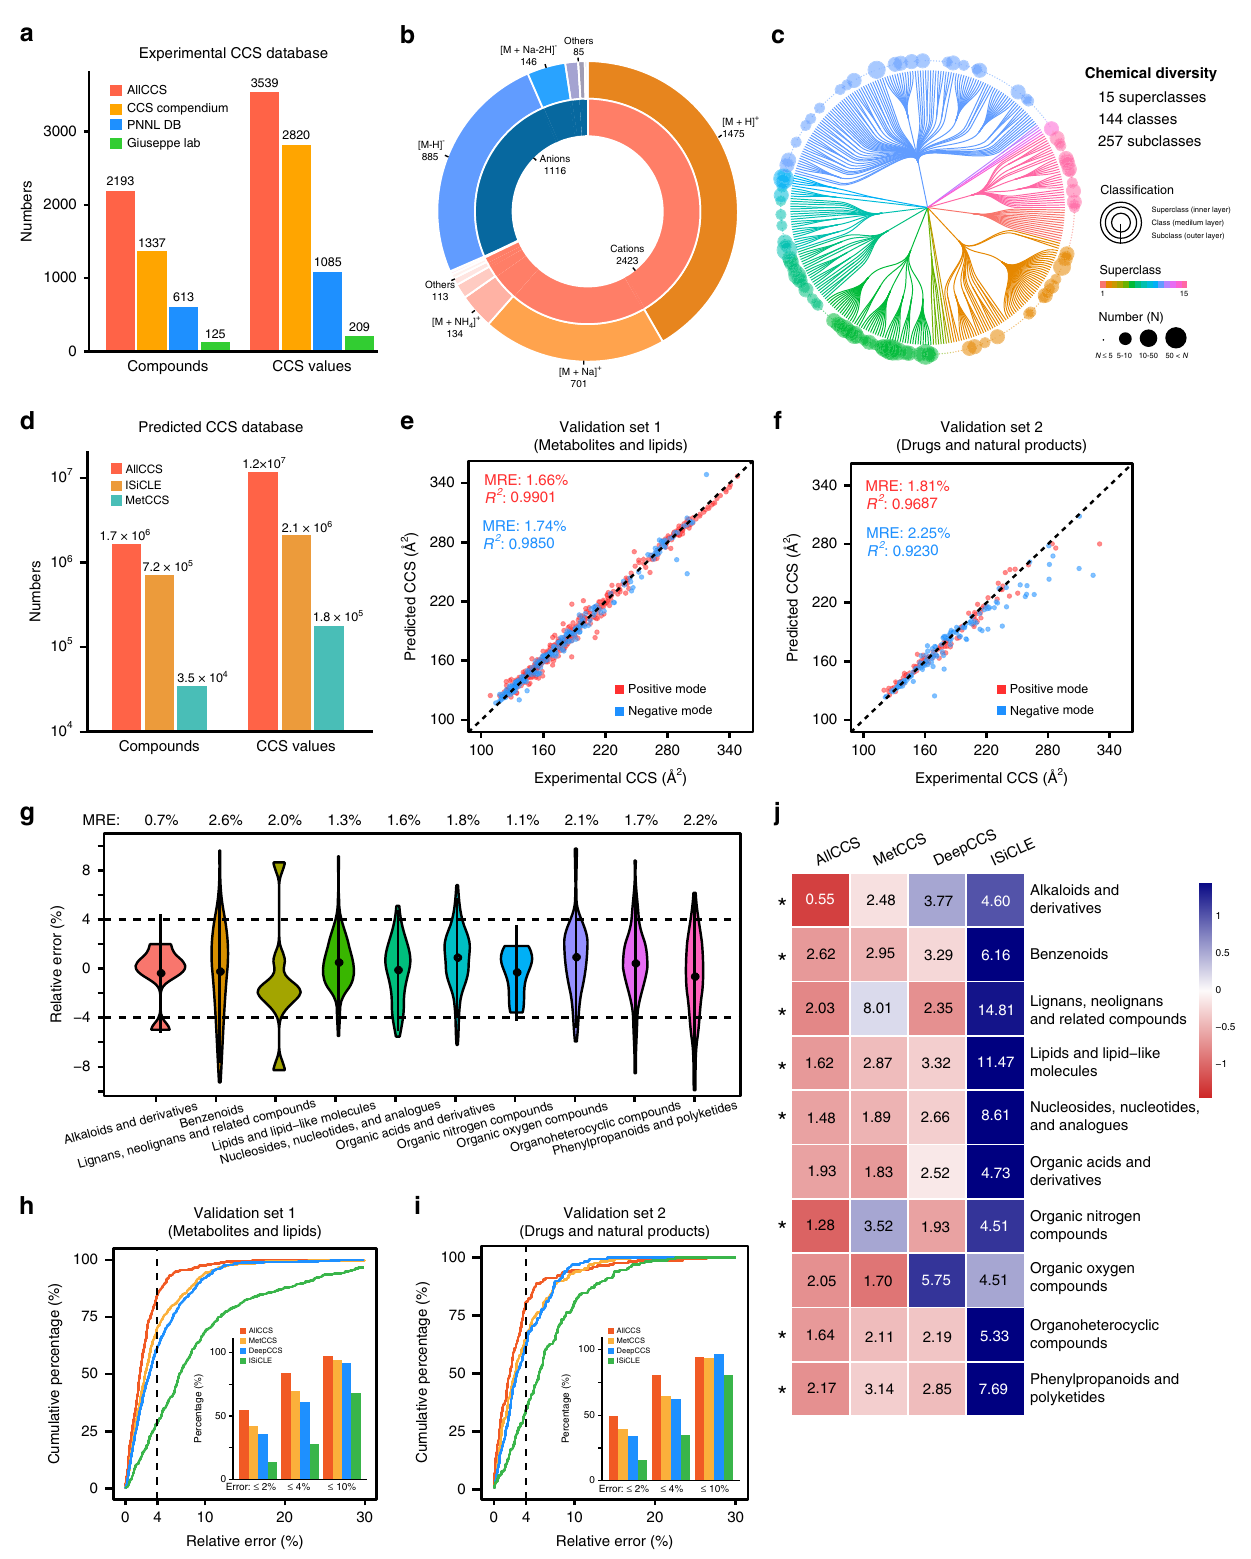
showed signi fi cantly larger errors after excluding lipids from the training set (Fig. 3b). We also observed that other super classes have similar prediction errors between before and after excluding lipids from the training dataset. Then, we repeated the process for each super class, and observed similar results (Fig. 3c). The results demonstrated that the prediction errors of the excluded super